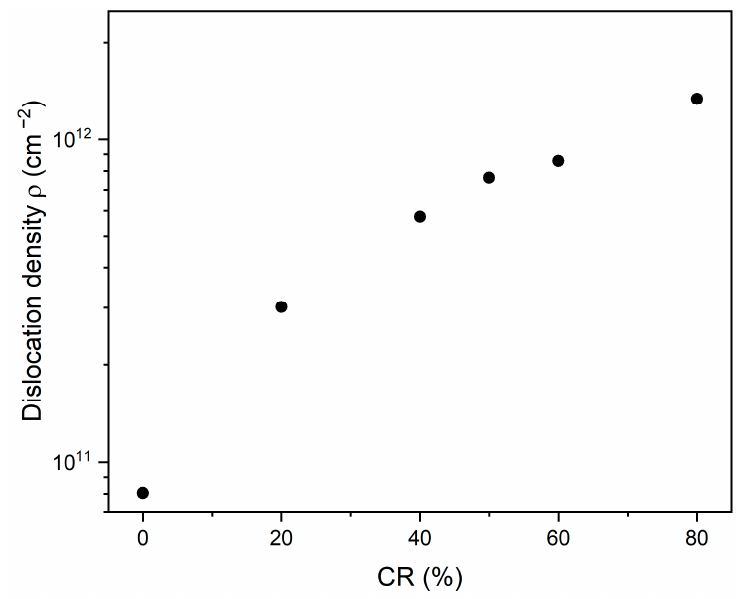
Figure 5. Effect of the CR ratio on the dislocation density ρ .